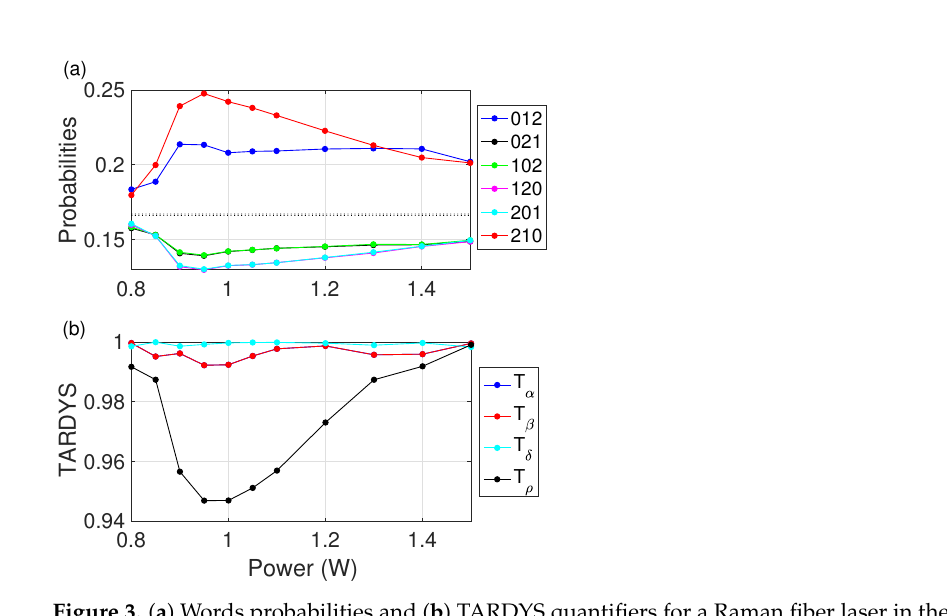
Figure 3. ( a ) Words probabilities and ( b ) TARDYS quantifiers for a Raman fiber laser in the laminar- turbulent transition (0.90 W ). Words are computed with the heights of the peaks in the output intensity. T ρ captures the transition in